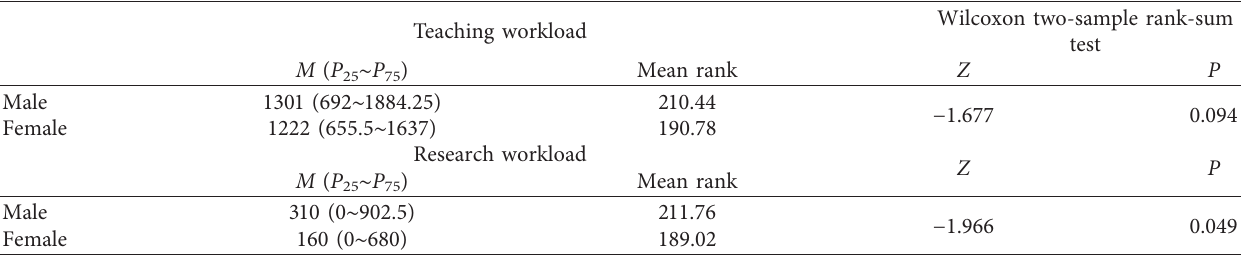
Table 6: Rank-sum test of teaching and research workload of teachers weak in both teaching and research.